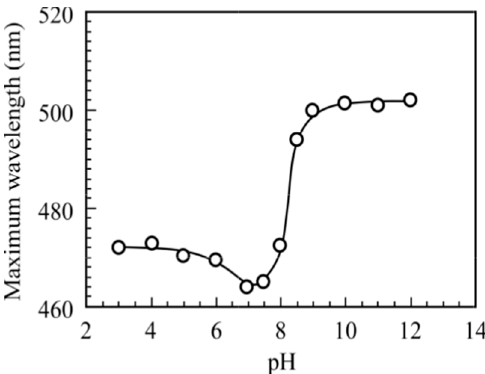
Figure 6. Wavelength of emission maximum in ANS fluorescence spectra as a function of solution pH in the presence of PAMPS–PAaU in 0.1 M NaCl aqueous solutions.